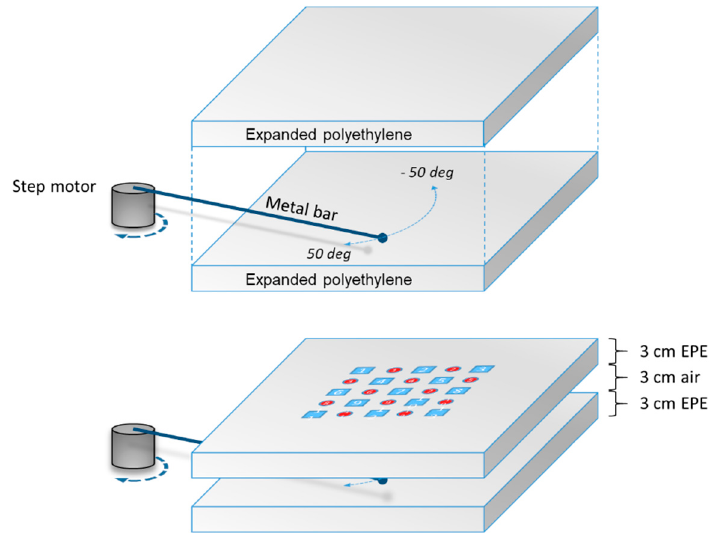
Figure 2. Scheme of the three-layer phantom with a mobile metal bar.